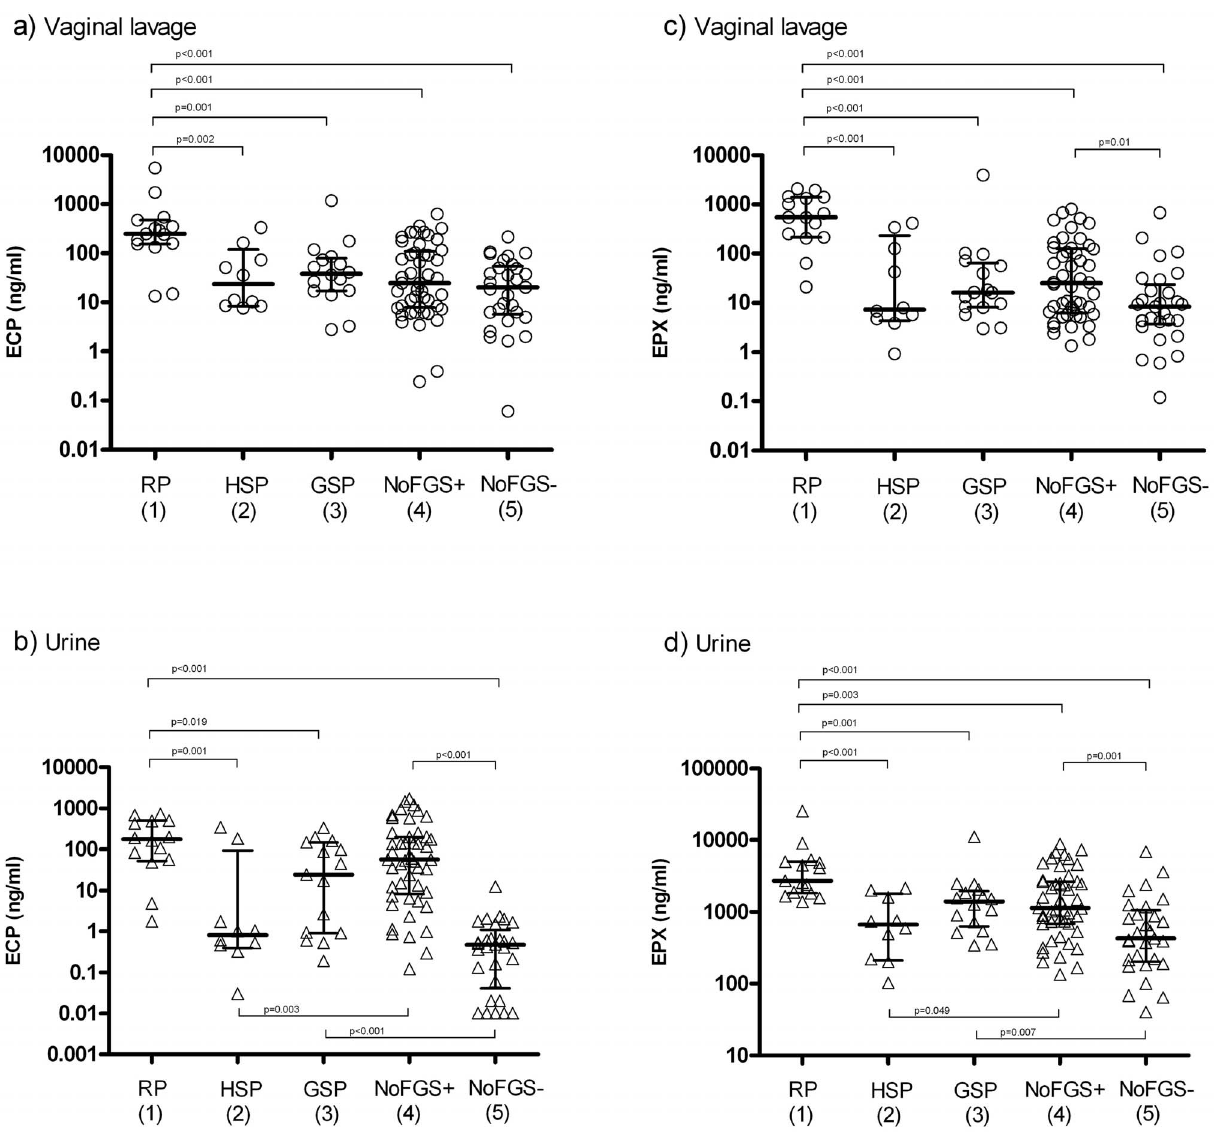
Figure 1. Dot plot illustrating the amount (ng/ml) of ECP in genital lavage (a) and in urine (b) and of EPX in genital lavage (c)) and urine (d) classified by pathology category 1–5 (see table 1). The plus and minus following ‘‘NoFGS’’ in group 4 and 5 refer to the S. haematobium egg status. The median is indicated with a horizontal bar and interquartile ranges shown. Only significant p values are shown on the graphs. For ECP in urine two extreme outlies were excluded (b). Note that the ordinate axis is on logarithmic